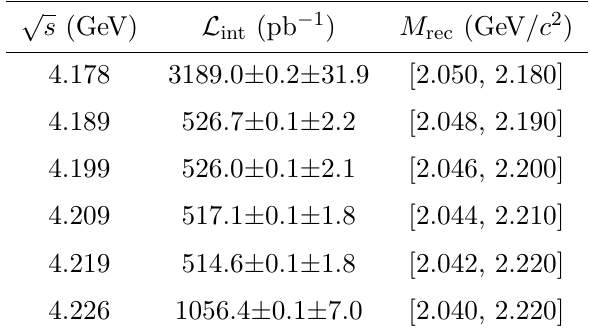
Table 2 . The integrated luminosities ( L int ) and the requirements on M rec for various C.M. energies. The definition of M is given in eq. (3.1). The first and second uncertainties are statistical and rec systematic,